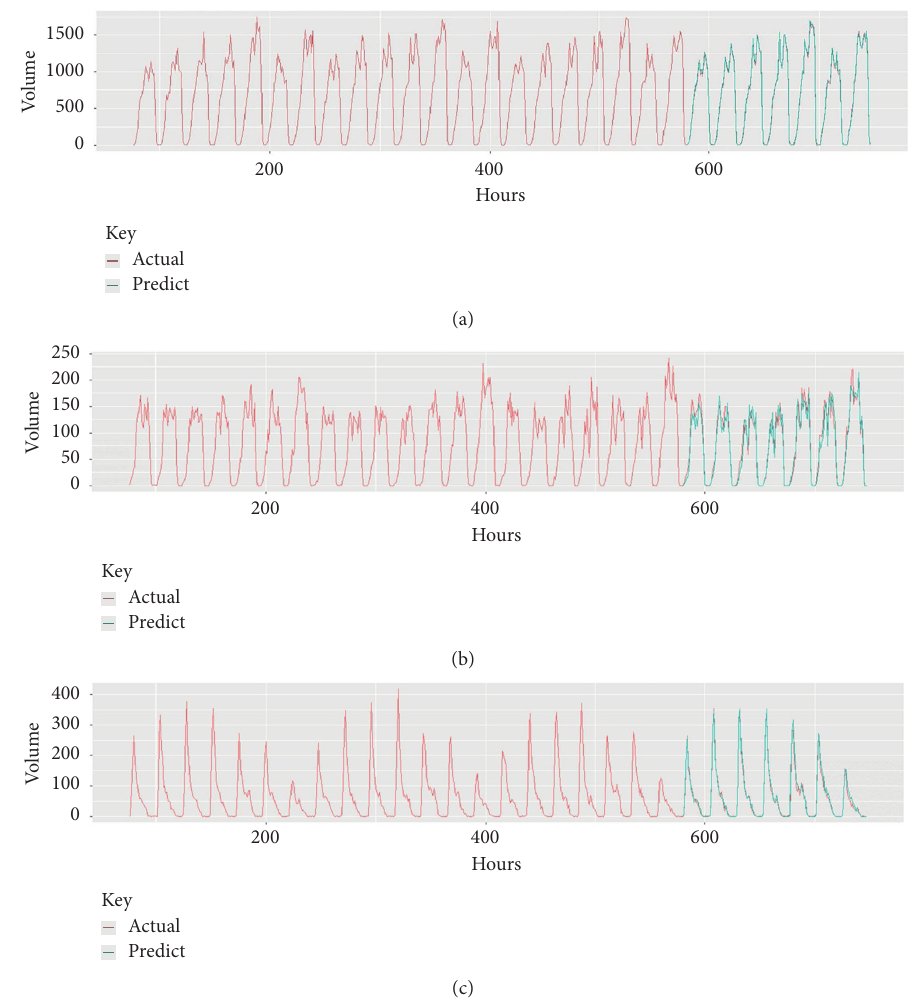
Figure 5: Comparisons of the forecast result of parking duration categories D1, D2, and D3. (a) The arrival parking volume forecast for the parking time category D1 (0 ∼ 2 h). (b) The arrival parking volume forecast for the parking time category D2 (2h ∼ 6h). (c) The arrival parking volume forecast for the parking time category D3 ( > 6 h).